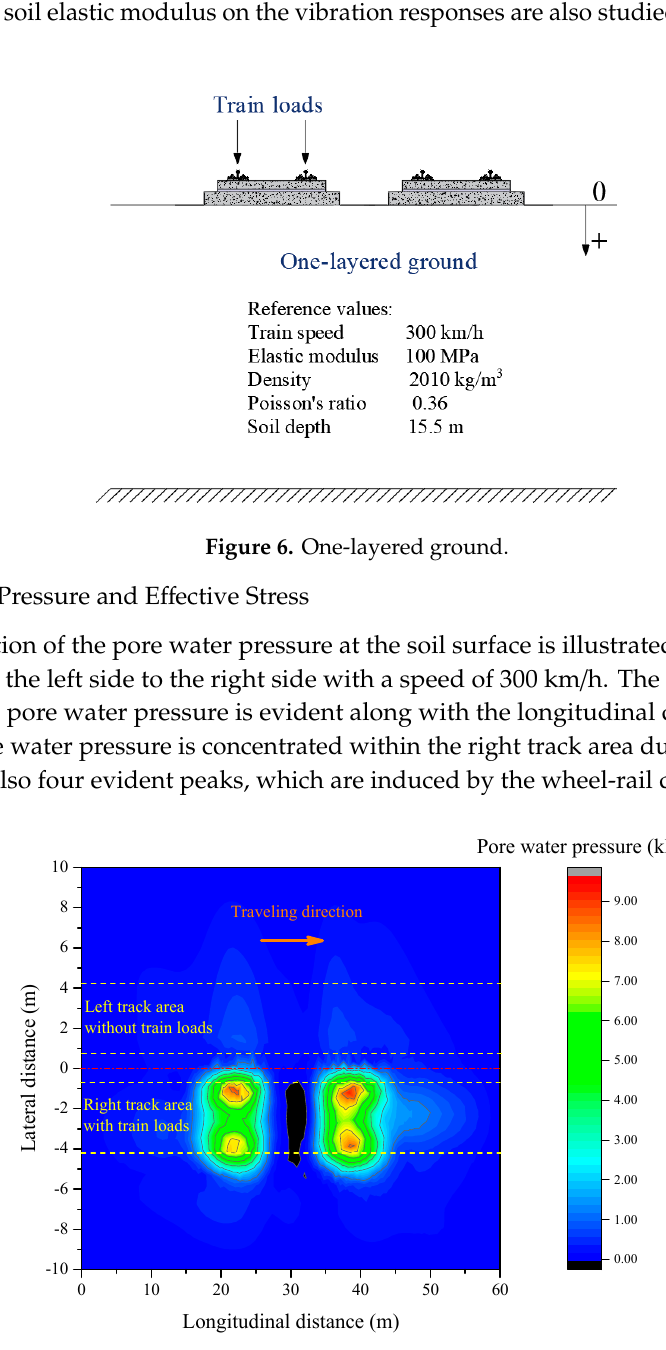
Figure 7. Distribution of the pore water pressure.